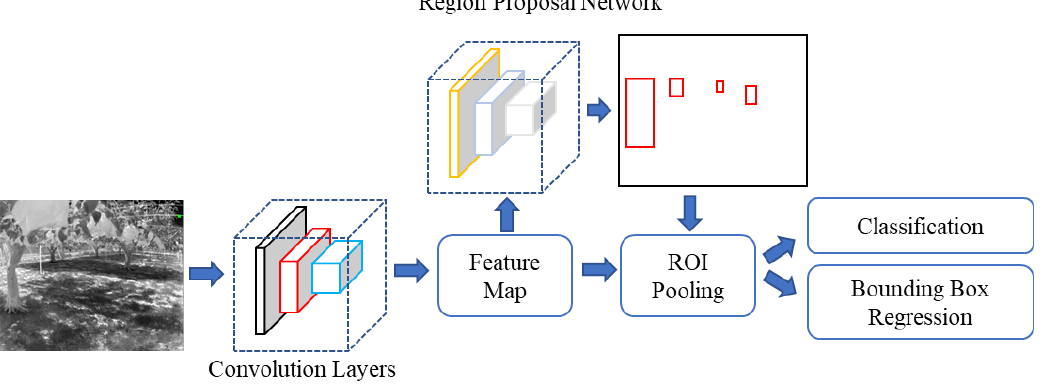
Figure 4. Faster R-CNN structure for tree truck detection used in this research. (1) Convolutional layers: As a CNN network target detection method, Faster